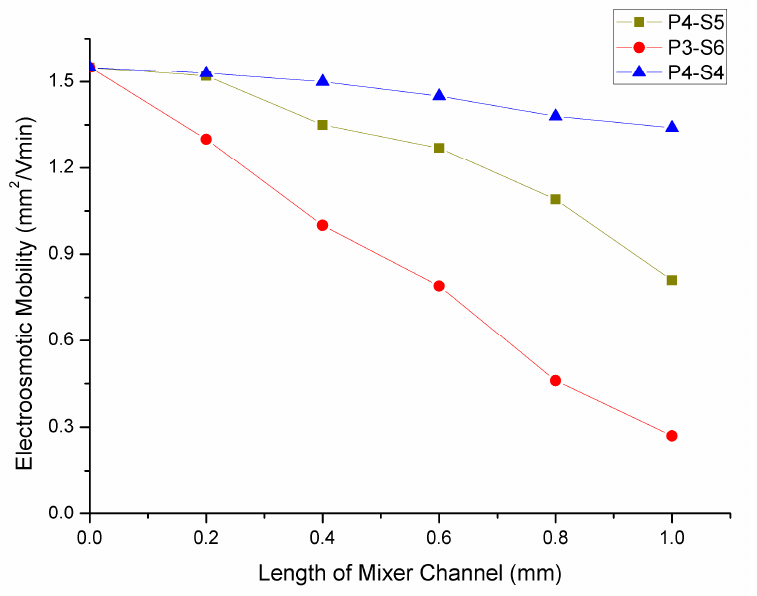
Figure 9. The electroosmotic mobility with various lengths of the mixing channel.